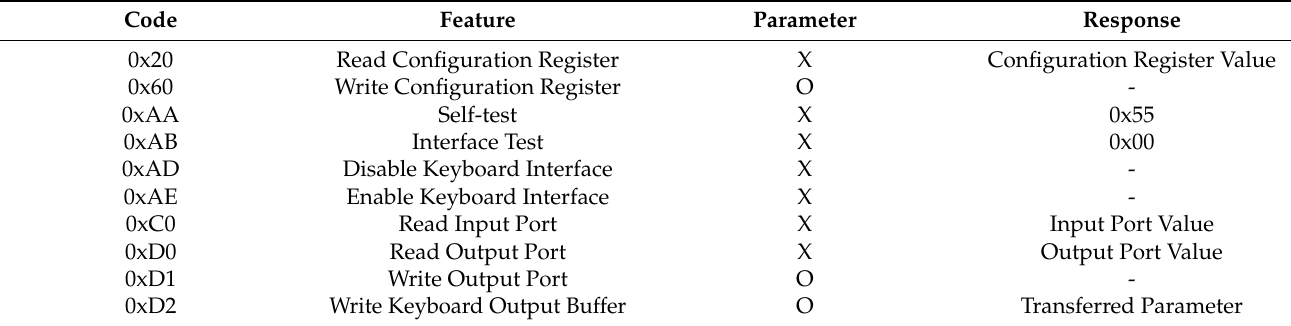
Table 3. Primary command codes of the keyboard